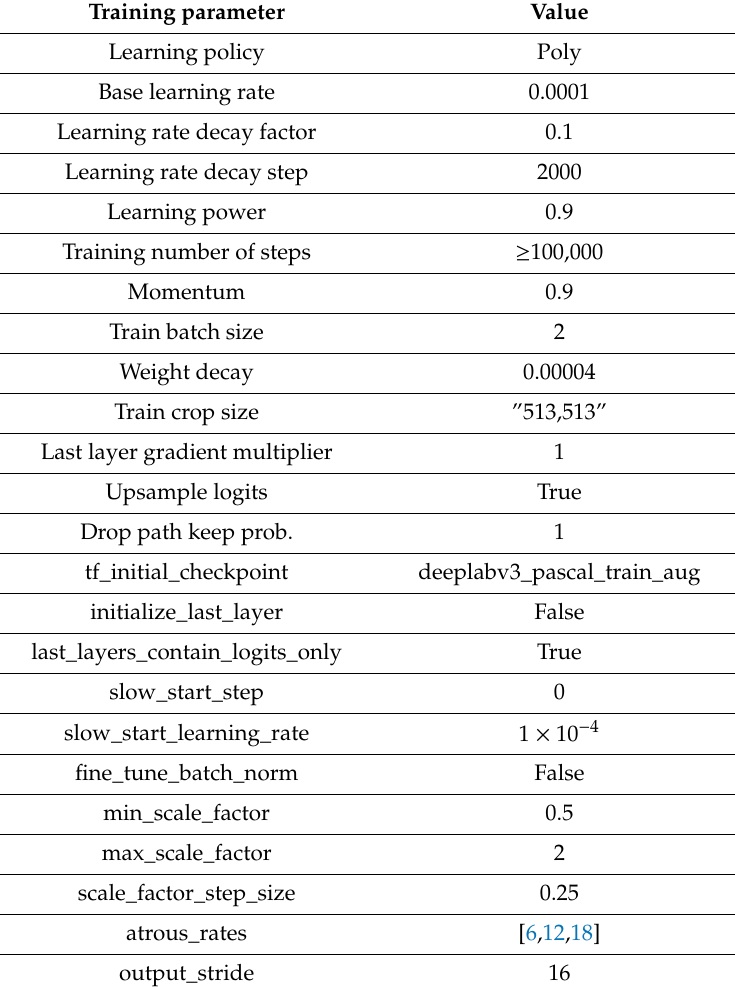
Table 1. Training parameters used in DeepLabV3 +